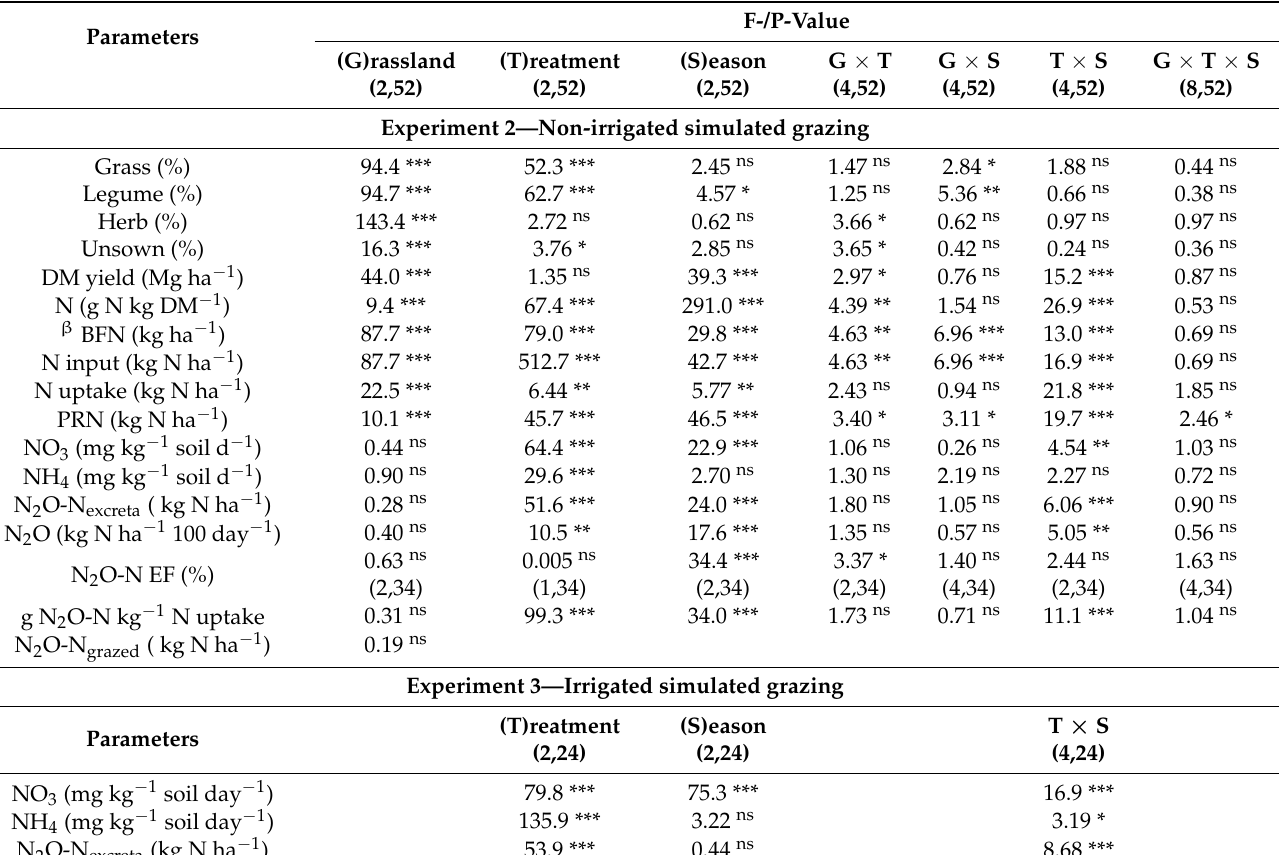
Table A2. Analyses of variance of the measured parameters showing main effects of pasture diversity (G), excreta type (T), and season (S) of excreta deposition on measured parameters.